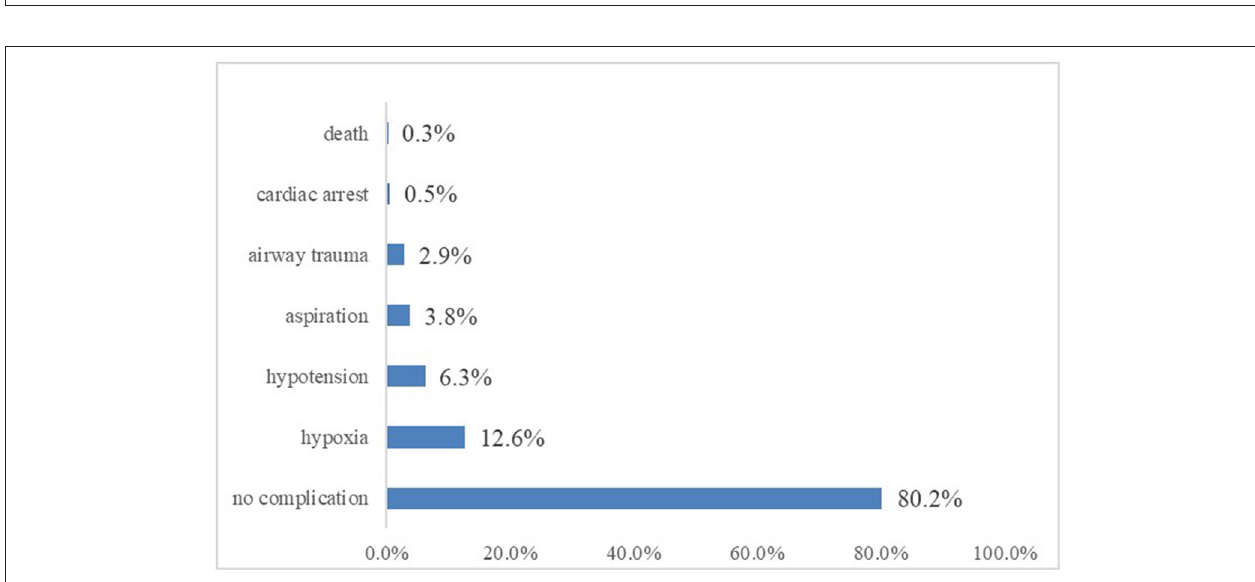
FIGURE 4 | Forest map of the risk of first-pass intubation attempt failure. The dotted line demarcates protective factors on the left and risk factors on the right. P < 0.05 represented statistically significant.